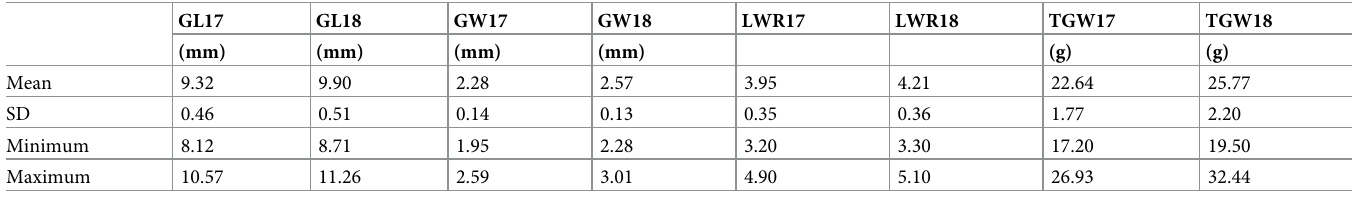
Table 1. Grain Length (GL), Grain Width (GW), grain Length-to-Width Ratio (LWR), and Thousand-Grain Weight (TGW) of the F 2 and its derived F 2:3 popula- tions in 2017 and 2018, respectively.